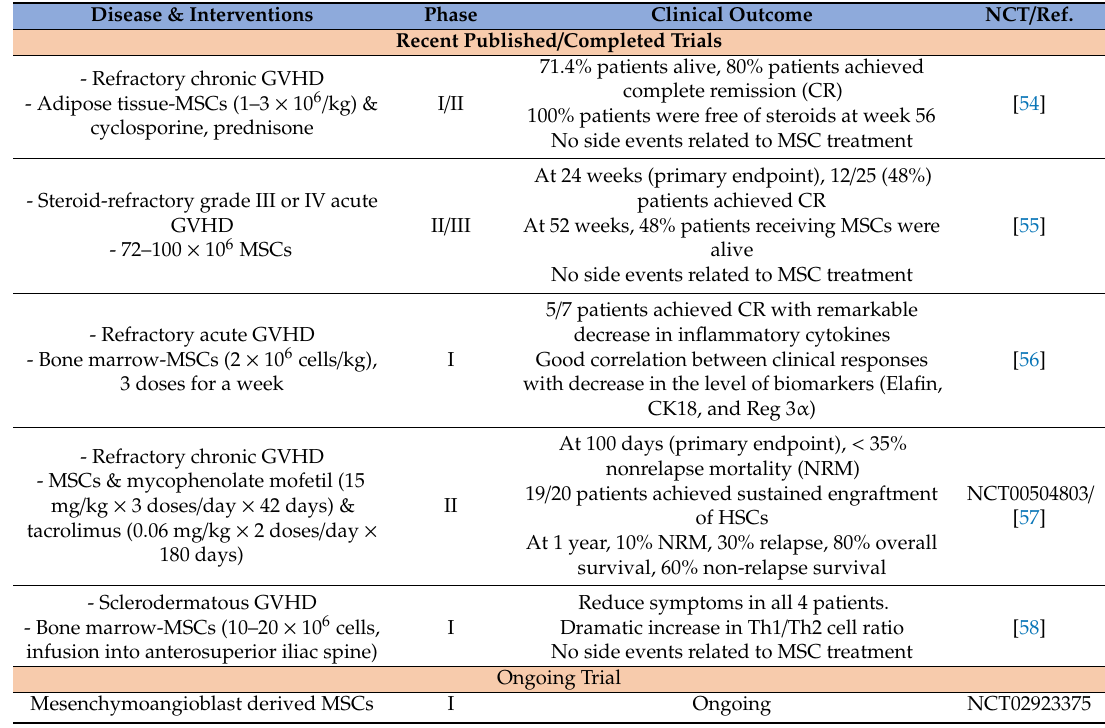
Table 1. Selected clinical trials testing the e ff ectiveness of MSCs on reducing GVHD caused by allogeneic HSC transplantation in cancer